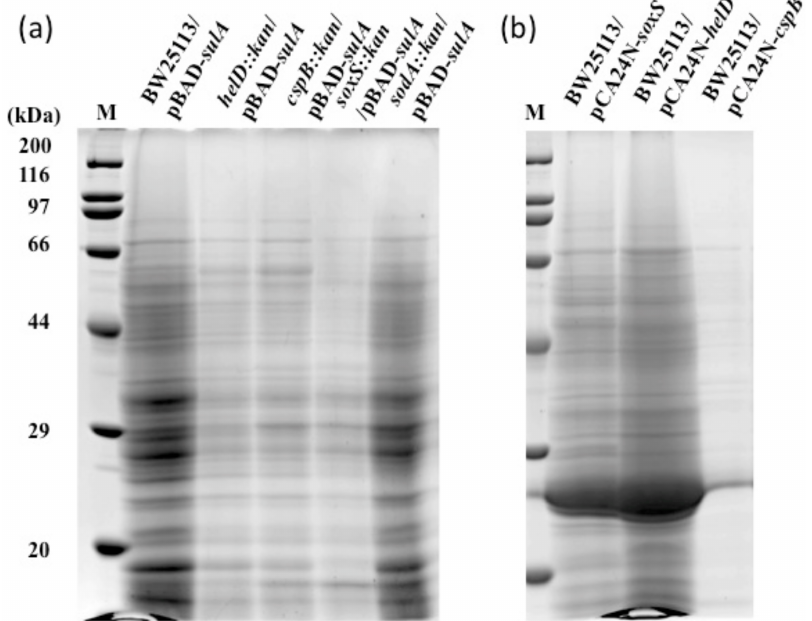
Figure 3. Effects of disruption or overexpression of selected up-regulated genes by overexpres- sion by sulA on SDCL. BW25113 helD :: kan , BW25113 cspB :: kan , BW25113 soxS :: kan , and BW25113 sodA :: kan cells harboring pBAD- sulA ( a ), and BW25113 cells harboring pCA24N- soxS , pCA24N- helD , or pCA24N- cspB ( b ), were grown in LB medium with ampicillin. L-Arabinose or IPTG was added at OD 600 of about 0.5 at the final concentrations of 0.1% and 0.1 mM, respectively. Cultures were sampled by removing portions at 24 h after induction. Sample preparation for SDS-PAGE was performed as described in the Materials and Methods